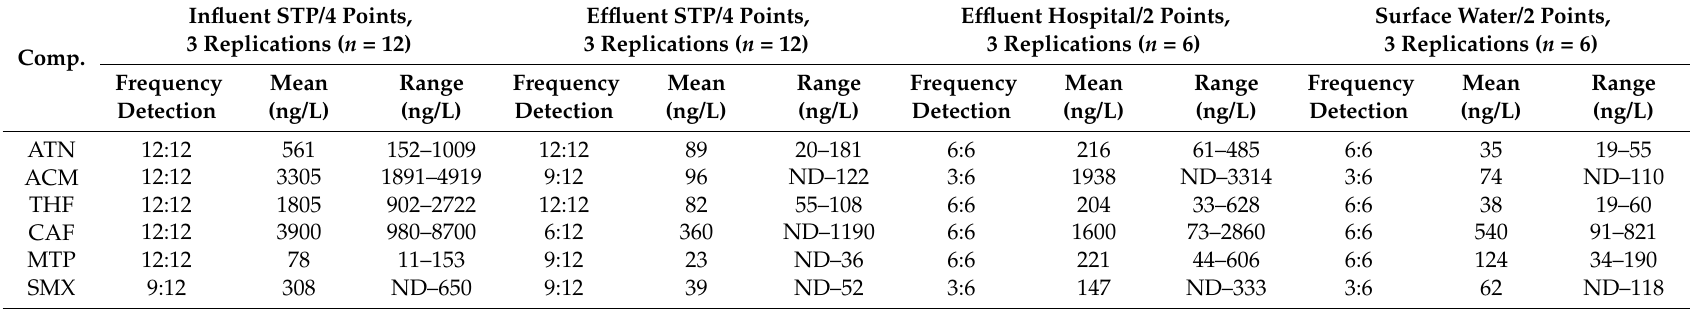
Table 6. Concentration of detected pharmaceuticals from surface water, STP influent and effluent, and HSP effluent.